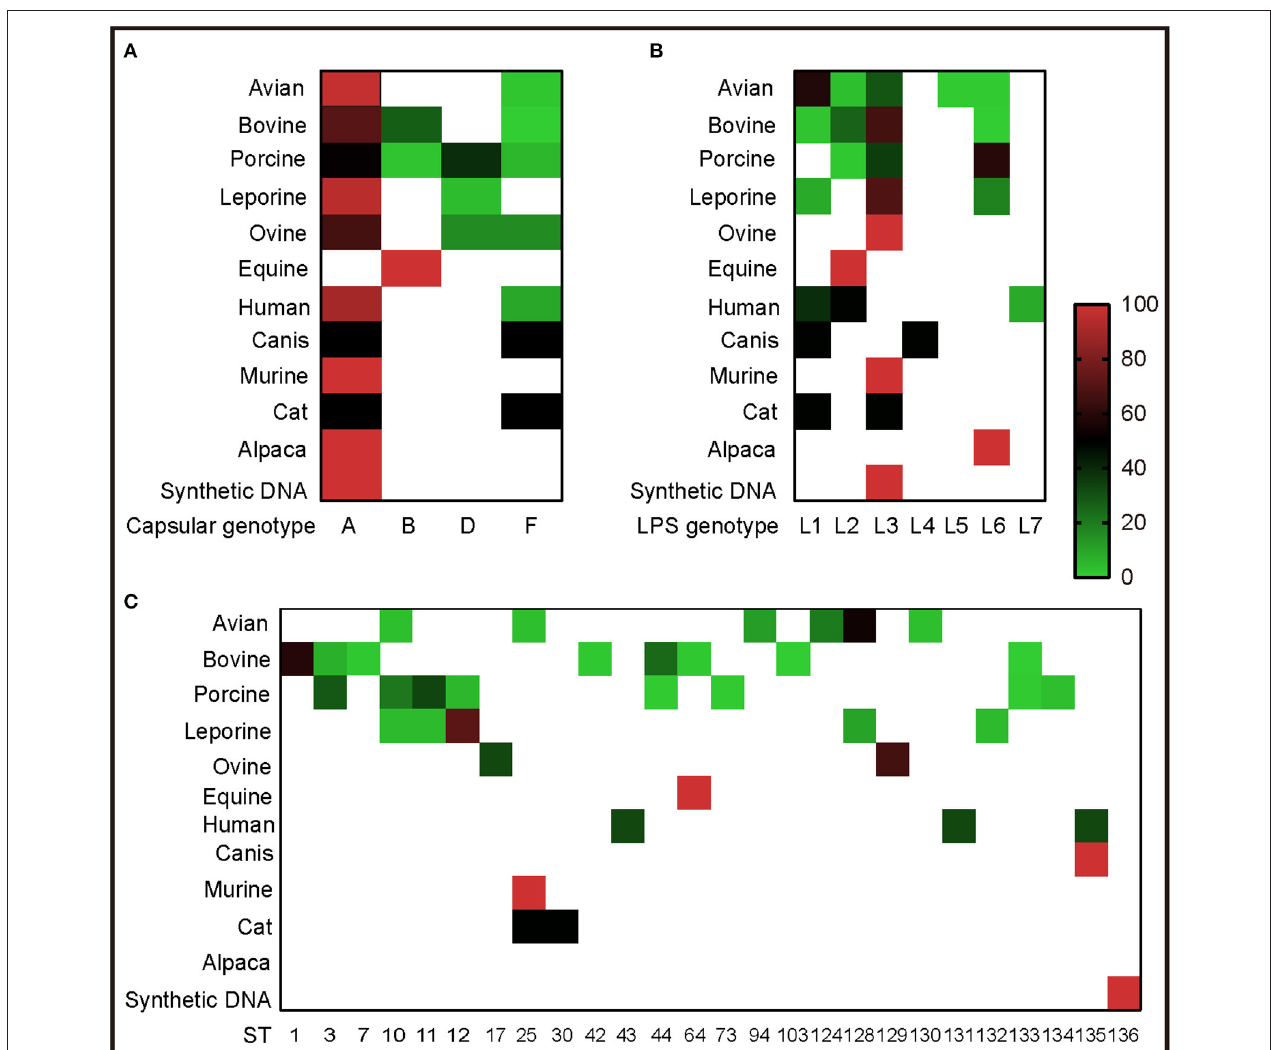
FIGURE 3 | Heatmap revealing the association between capsular/LPS/MLST genotypes and P. multocida strains from different host species determined by PmGT. (A) Heatmap revealing the association between capsular genotypes and P. multocida strains from different host species; (B) Heatmap revealing the association between LPS genotypes and P. multocida strains from different host species; (C) Heatmap revealing the association between MLST genotypes and P. multocida strains from different host species. Percentages of sequences typed are shown with different colors displayed at right